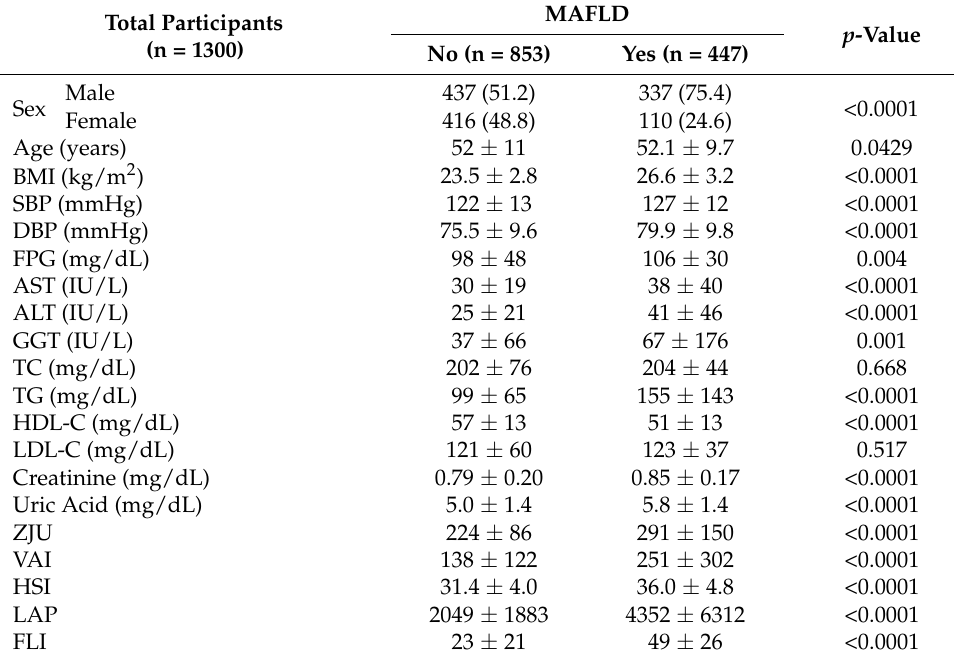
Table 2. General characteristics of the study